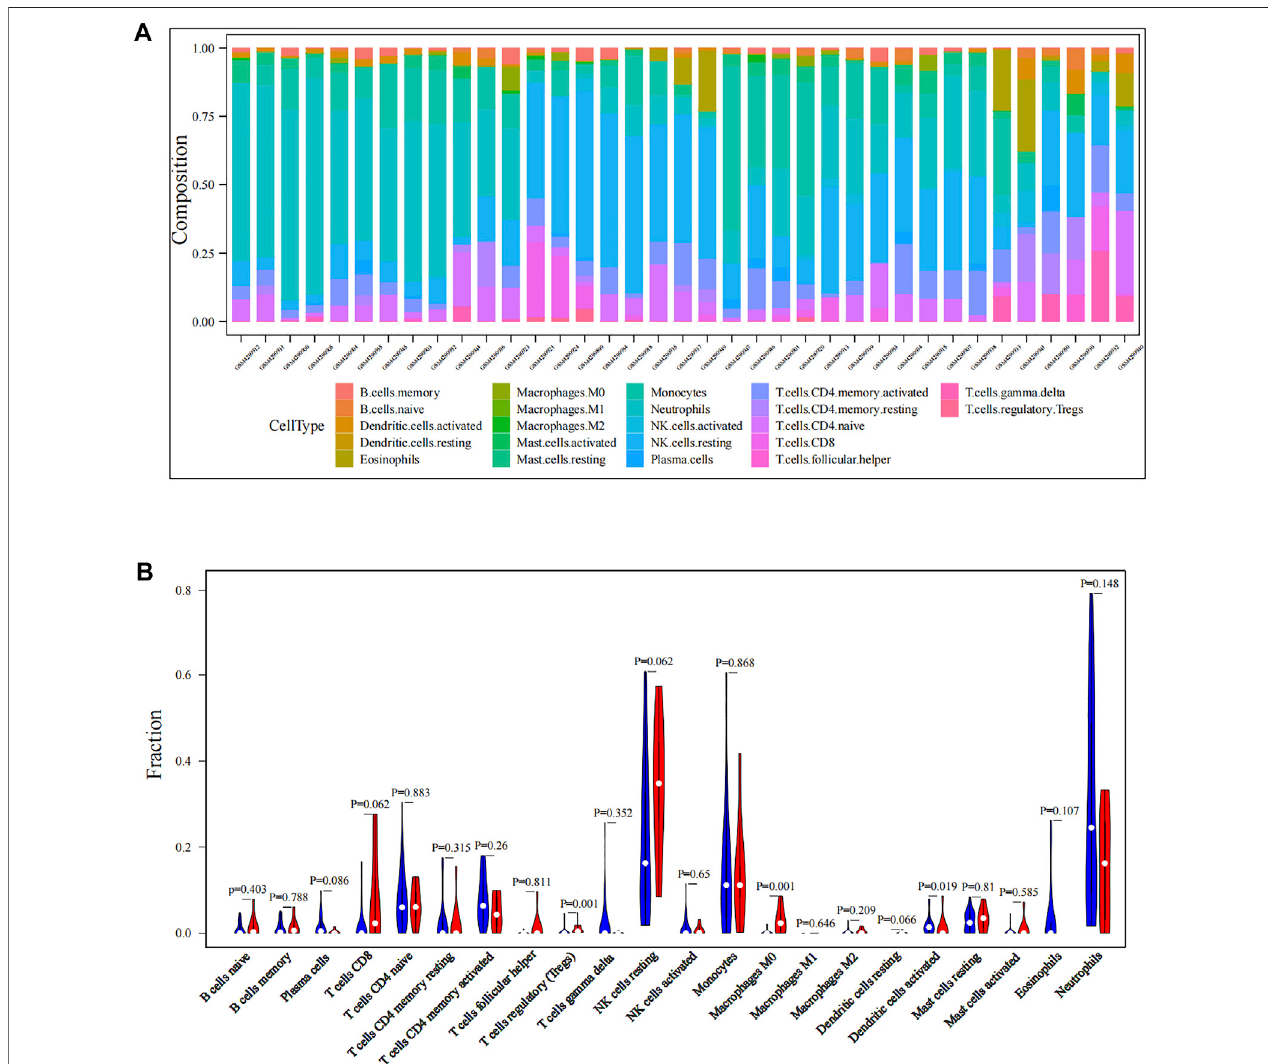
FIGURE2 | Immune in fi ltration levels of CTCs in PDAC patients. (A) Landscape of immune in fi ltration in CTCs of PDAC patients. (B) Analysis ofdifferential immune cells between localized PDAC and metastatic PDAC. CTCs, circulating tumor cells; PDAC, pancreatic ductal adenocarcinoma.